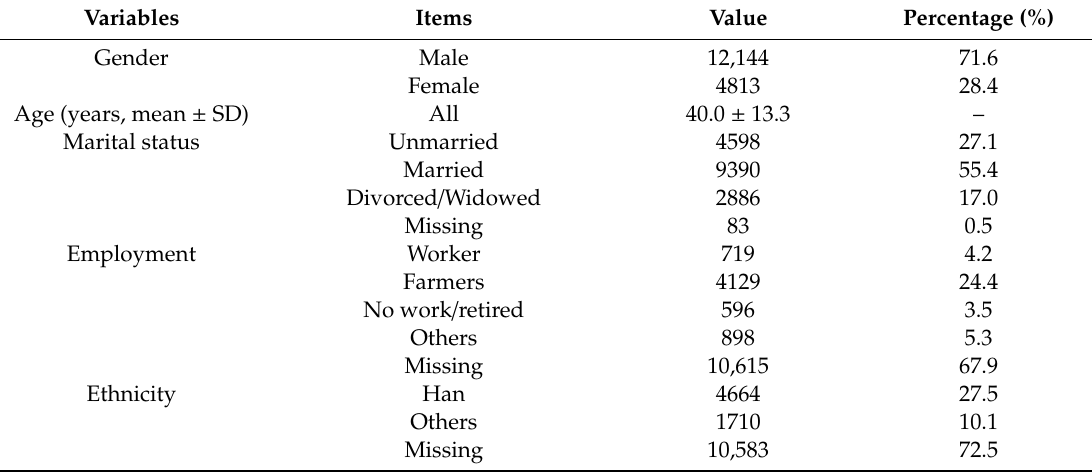
Table 2. Characteristics of people infected with HIV during